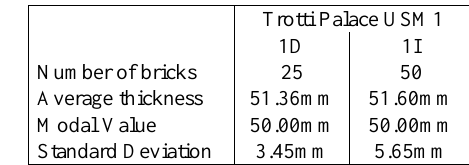
Table 3. Data evaluation from the USM1 of Trotti Palace.